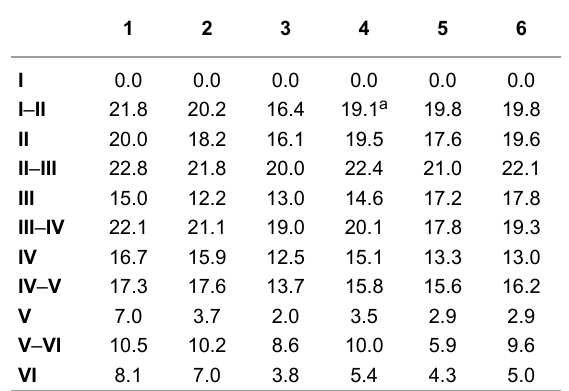
congeners. When the saturated NHC is considered, the substitu- tion reduces dramatically the barriers of the first two transition states. Then the cycle I → VI is more exothermic with the substi- tuted systems. On the other hand, the unsaturated system does not reduce the energy barriers with the substituted indenylidene moieties, because of the rigidity of its backbone. And the